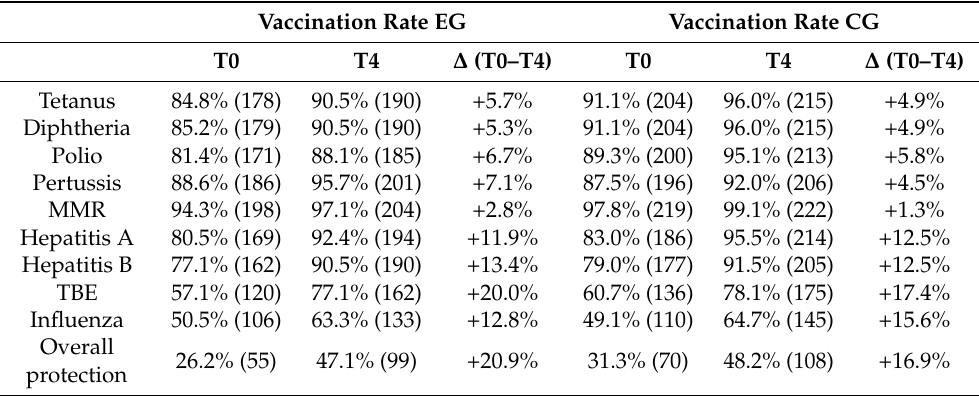
26.2% (55) 47.1% (99)